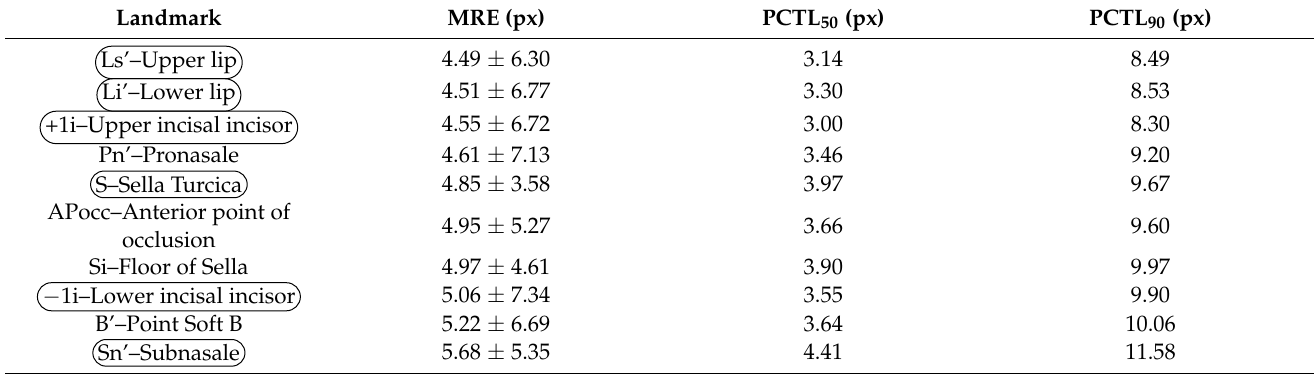
Table 8. Ten cephalometric landmarks from the AUDAX database detected most accurately by the SCN-EXT method. For denotations, see Tables 2 and 6.